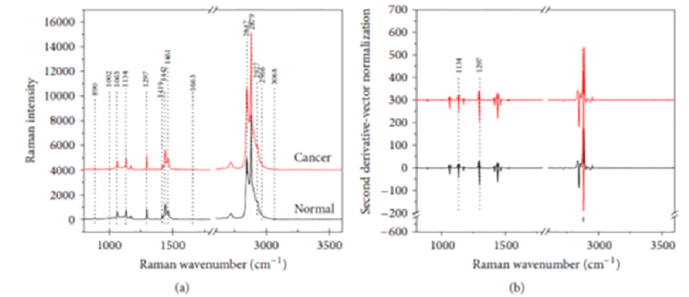
Figure 11. ( a ) Averaged Raman spectra for normal ( n = 78) and cancerous ( n = 81) colorectal tissues. ( b ) Second derivative-vector normalized spectra of Raman spectra from normal and cancerous tissues. The broken interval (-//-) indicates the region of 1800–2600 cm − 1 , which does not contain tissue-related biochemical information [151].